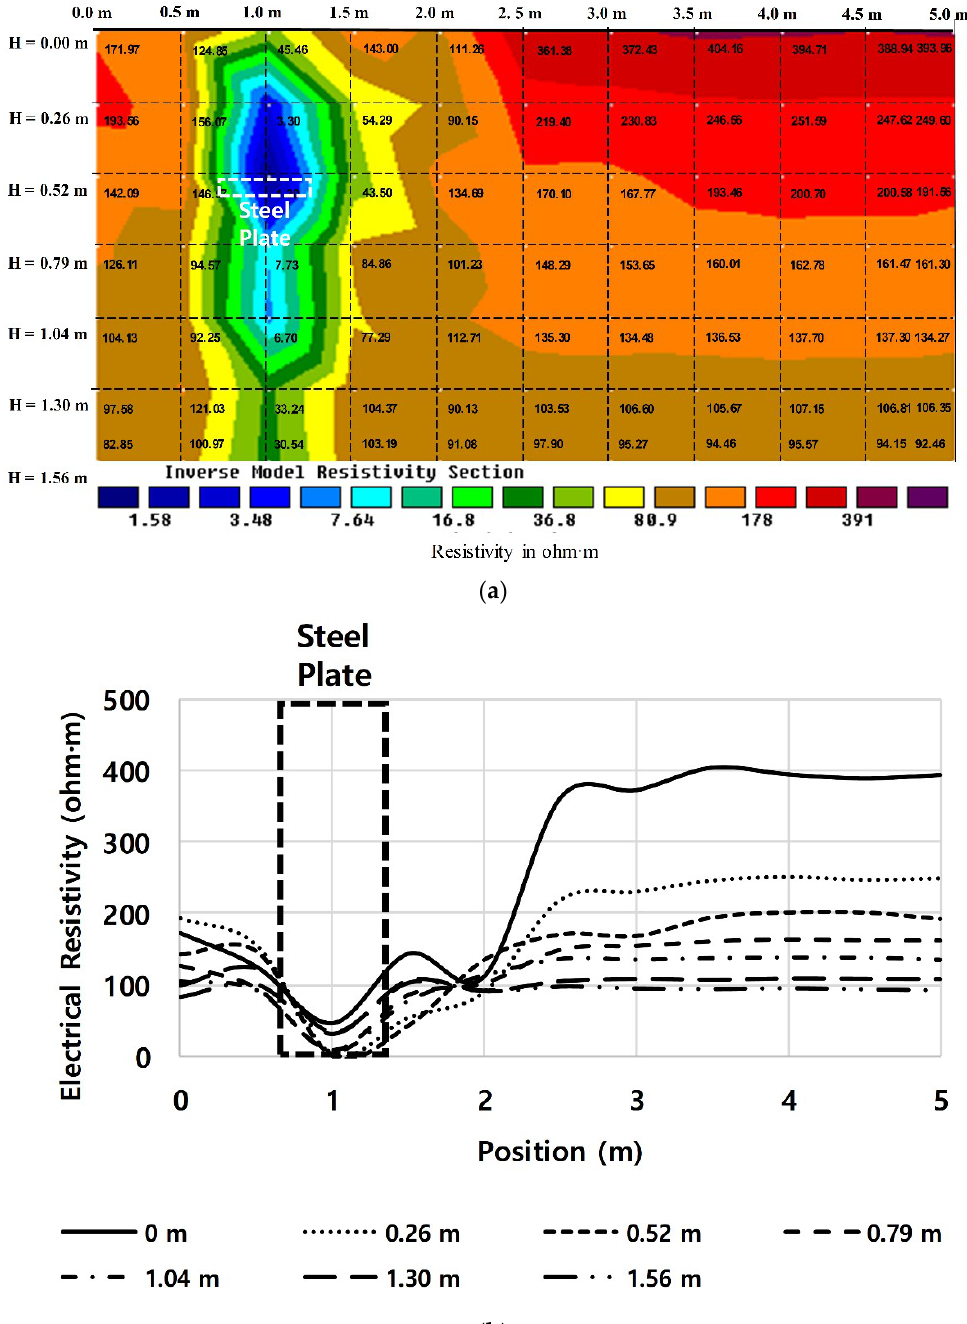
Figure 11. Test result for the steel plate (Section No. 7). ( a ) Distribution of the ER. ( b ) ER according to the position at each depth.